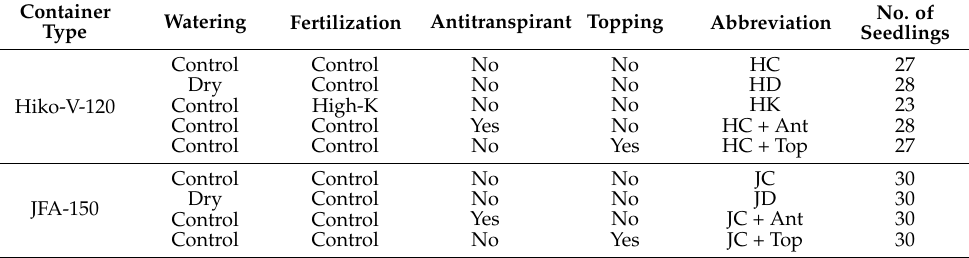
Table 1. Details of each treatment used in the summer planting